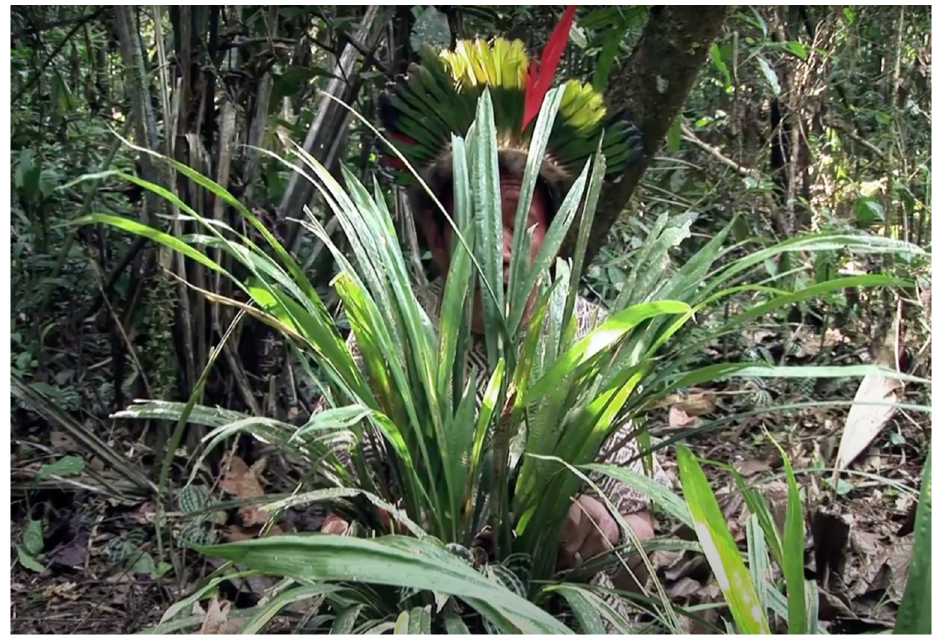
Figure 4. Still from Shuku Shukuwe .